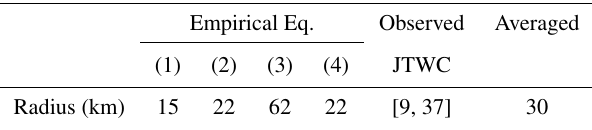
Table 4. The estimated value of the radius of maximum wind when P 0 is 880hPa. Empirical Eq.